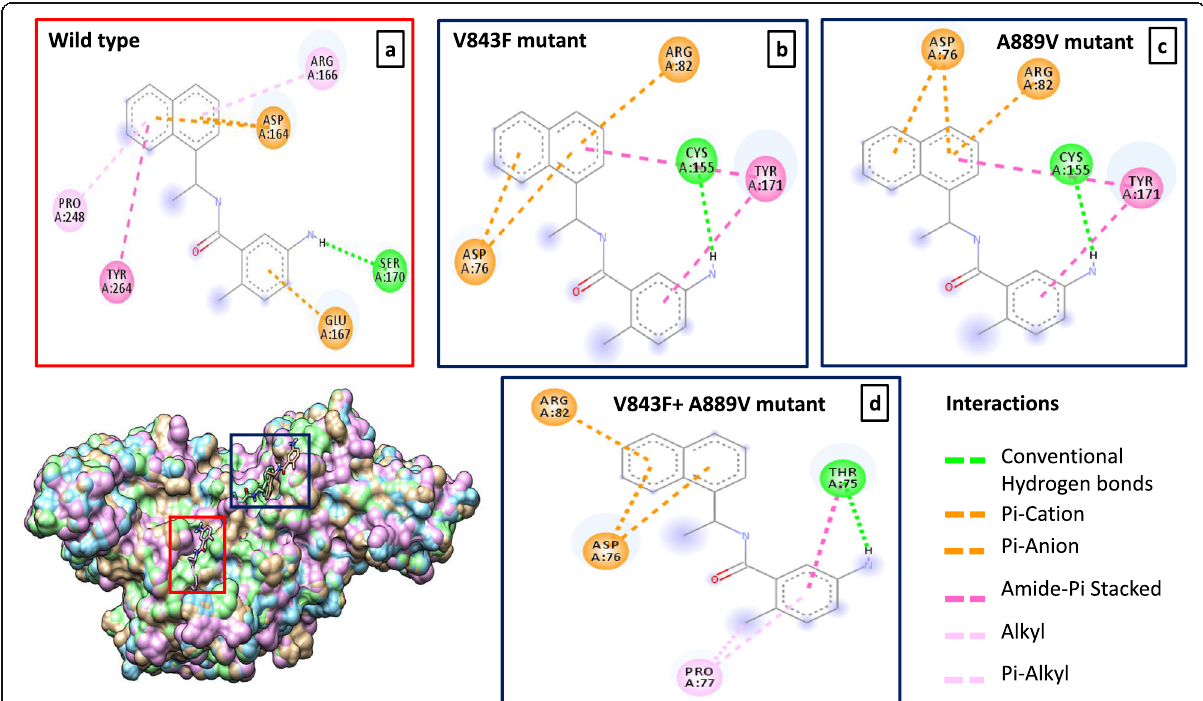
Fig. 2 Interactions between GRL0617 inhibitor and superimposed SARS-CoV-2 wild type and mutant papain-like viral proteases ( a – d ). Interacting amino acid residues in wild-type and PLPro mutant SARS-CoV-2. Inhibitor binding into the wild type and mutant protein. The red and blue boxes indicate the location and the interactions between ligand and receptors in wild and in mutant proteases,